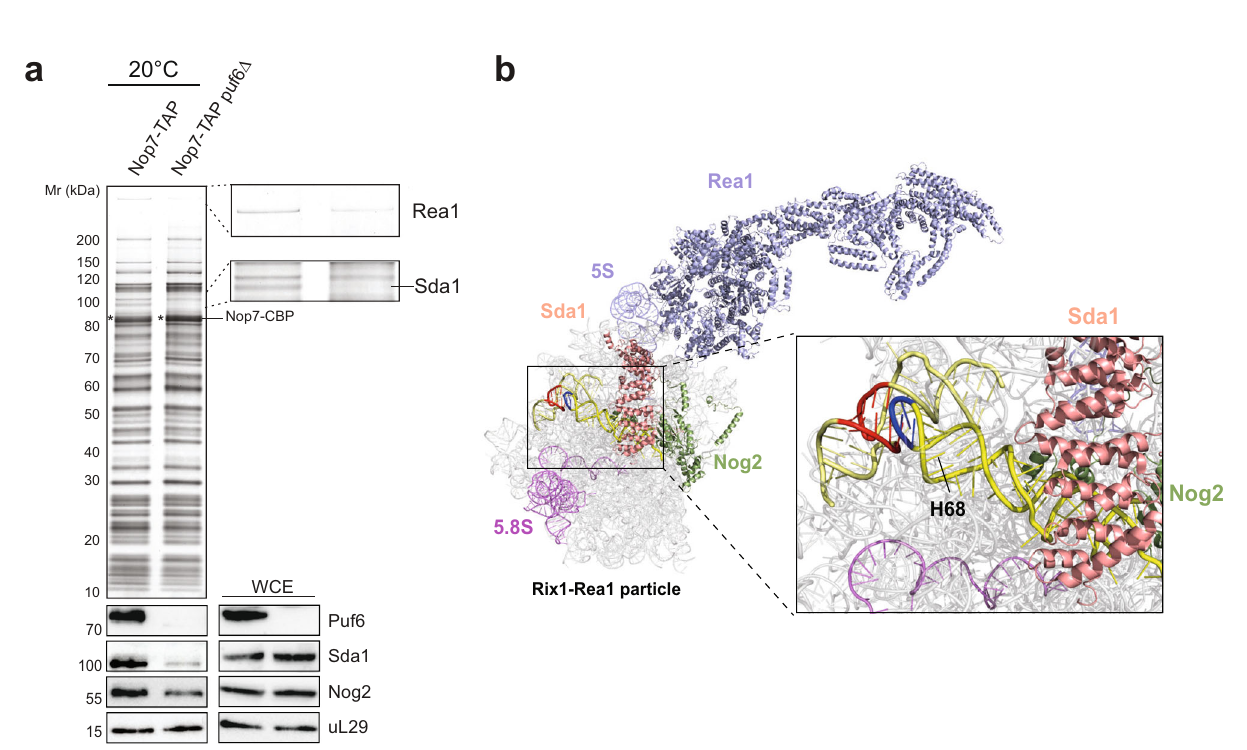
Fig. 6 Puf6 ushers rRNA tertiary contact formation. a Tertiary contact between H22-H88 kissing loop (KL, in red) and H68 tip (GAAA in blue) within 25S rRNA (left; PDB ID: 4V7R), Mg 2 + in green. Middle: tertiary contact between H22-H88 KL (in red) and H68 tip (GAAA in blue) within 28S rRNA (PDB ID: 4UG0) Right: knowledge-based structure prediction of the RNA construct (colored) matches well (RMSD = 1.6 Å) with the tertiary contact within 25S rRNA (gray). Dotted lines indicate poly-A linkers. b Events leading to tertiary contact formation (nucleolar particles, PDB ID: 6CB1 (ref. 6 ); NE1 and NE2 particles, PDB ID: 6YLX and 6YLY (ref. 8 ); nuclear particle, PDB ID: 3JCT (ref. 17 )). Puf6 functions between NE2 and Nog2 particle, in dashed-line oval. c FRET ef fi ciencies for 1 µ M Cy3s (donor)/Cy5s (acceptor) labeled RNA: KL, KL-TL GAAA , and TLR-TL GAAA (cartoons above plots, Supplementary Table 3) were plotted against indicated K + (left panel; 20 mM HEPES buffer) or Mg 2 + (right panel; 20 mM HEPES, 100 mM K + ) with (red circles) or without (black circles) 10 µ M GB1-Puf6-PUM (161 – 656). d FRET increase upon addition of K + (in blue), Mg 2 + (in green), and 10 µ M GB1-Puf6-PUM (in absence of Mg 2 + , in red) for KL, KL-TL GAAA and TLR-TL GAAA RNA constructs. Each independent experiment is presented (dots), and error bars indicate ±SD of n > 2 independent experiments. e UV thermal melting curves for KL-TL GAAA in 20 mM HEPES buffer containing 100 mM K + (top) and 100 mM Mg 2 + (bottom). Horizontal arrow: KL melts at a higher temperature in presence of Mg 2 + ; vertical arrow: melting transition corresponding to KL-TL GAAA docking in presence of Mg 2 + . f Scheme for KL-TL GAAA formation in presence of K + , Mg 2 + , and Puf6. g In total, 2.5 nM Cy5-labeled H68- or H68-H88-H22-RNA was titrated with 0.16 nM to 20 µ M Puf6-PUM(161 – 656). Fluorescence anisotropy was measured using a Tecan Sa fi re II plate reader. Puf6 binding to H68 alone and to